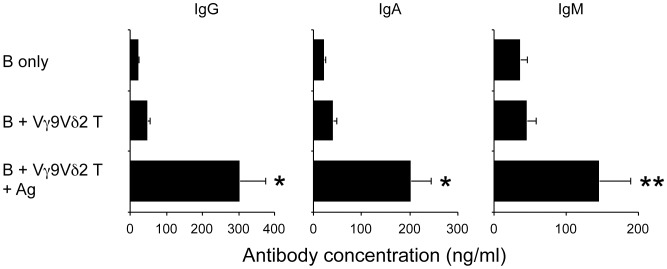
Vγ9Vδ2 TFH cells help B cells for antibody production.Vγ9Vδ2 T cells were cultured with an equal number of irradiated DCs and IPP, in the presence of IL-21. At the end of culture, Vγ9Vδ2 TFH cells were sorted, and cultured with CD19 B cells isolated from the tonsil of the same donor, in the presence or absence of IPP. Ten days later, total IgG, IgA and IgM levels in culture supernatants were assessed by ELISA. *p<0.001 and **p<0.02 when compared with the group consisting of B cells cultured with Vγ9Vδ2 TFH cells but in the absence of antigen. One out of five independent experiments is shown.